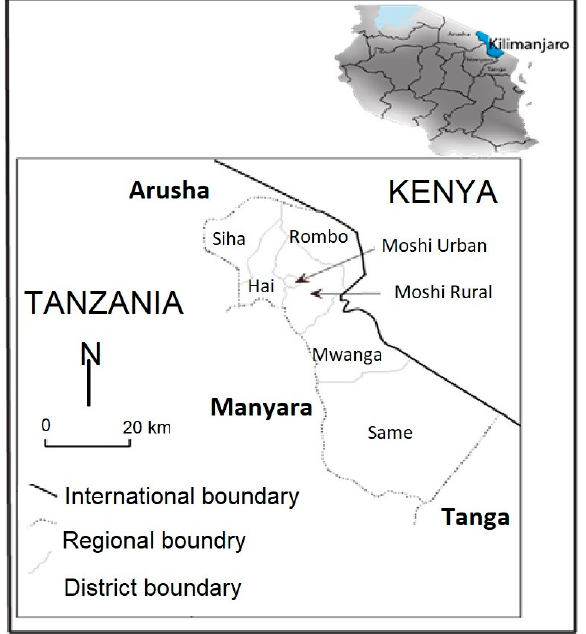
Figure 1. The Kilimanjaro region showing some of the places mentioned in this paper (image courtesy of Valence Silayo). Human settlement history of the Kilimanjaro region remains scanty. Evidence from western Kilimanjaro suggest a human presence since Neolithic times [21], while pottery from Marangu, east of the mountain, points to Iron Age farmers during early first millennium AD. Elements associated with ancestral Chagga settlement such as irrigation and associated water infrastructures date some 400–500 years ago [22]. Recent work [10] provides evidence of complex forms of settlement incorporating furrow construction and water management dating from the mid-fifteenth century AD. This is supported by early visitors to Kilimanjaro [4,19,23,24]. Bishop Hannington recorded an account from Mangi Mandara of Moshi, who claimed ancestry going back fourteen generations, which, according to oral traditions would date Chagga settlement in the Kilimanjaro region to the mid-first millennium AD [24].